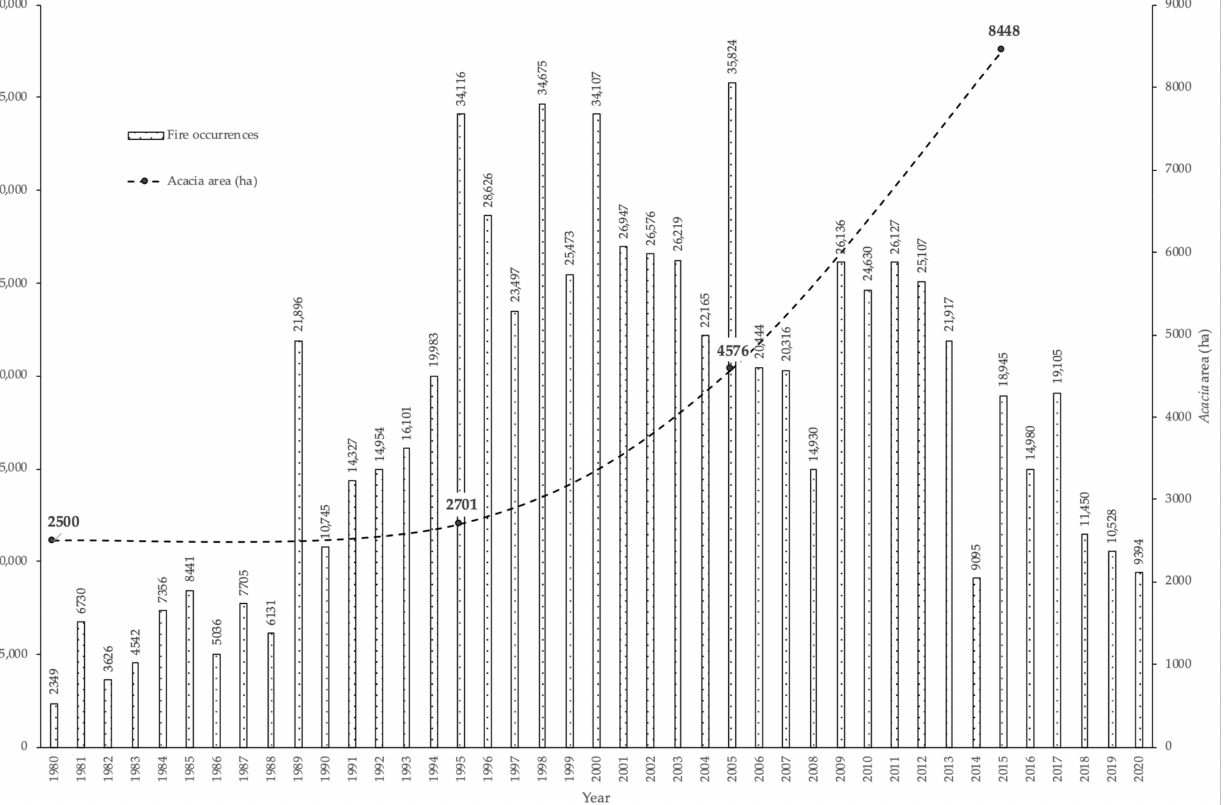
Figure 2. Evolution of the A. dealbata area (data collected from www.icnf.pt, accessed on 12 January 2021, and